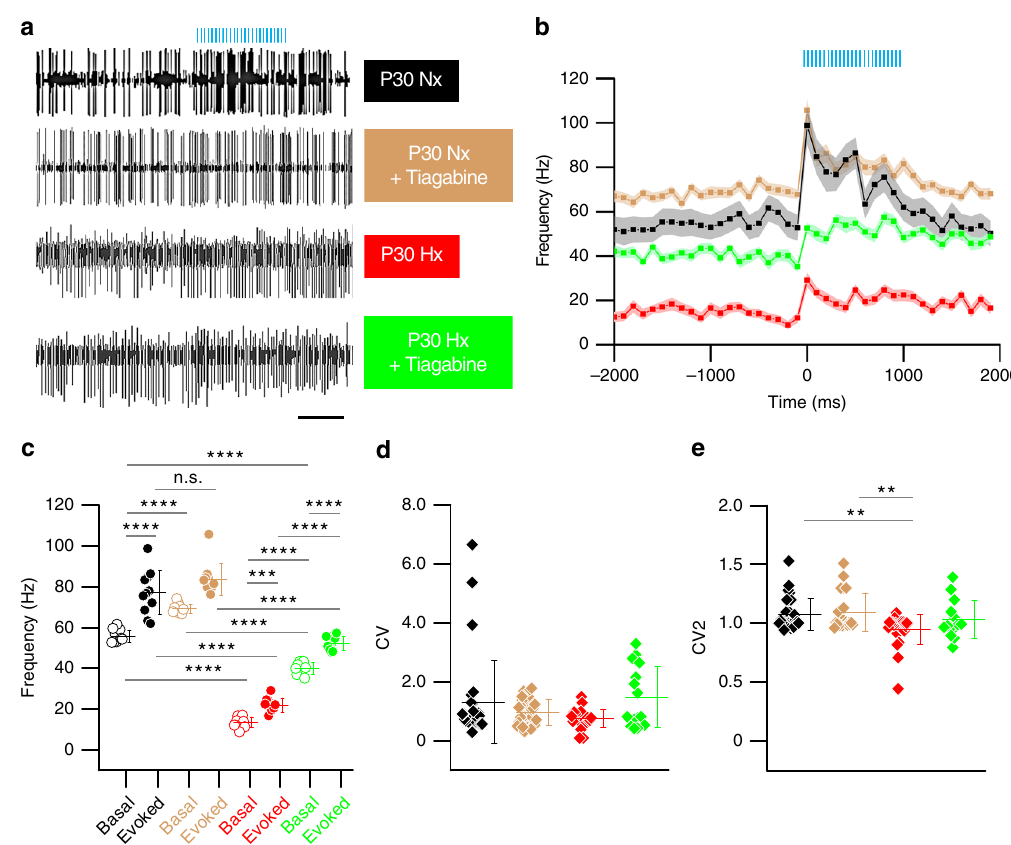
Fig. 8 Pharmacological intervention improves PC simple spike fi ring frequency in Hx Pcp2-Cre mice in vivo. a Representative MEA recordings from PCs in untreated P30 Nx (black), Tiagabine-treated P30 Nx (light brown), untreated P30 Hx (red), and Tiagabine-treated P30 Hx (green) animals. Scale 500 ms. b Mean SS fi ring frequency in animals from untreated P30 Nx group (black, n = 31 PCs, SEM — light grey), Tiagabine-treated Nx group (light brown, n = 37 PCs SEM — light tan), untreated Hx group (red, n = 25 PCs, SEM — light red), and Tiagabine-treated Hx group (green, n = 18 PCs, SEM — light green) obtained from 8 – 10 animals per group. c Scatter plot SS fi ring frequency comparison across groups as indicated by legend in a . For all groups, open circles represent basal fi ring and solid circles represent evoked (optostimulated) fi ring. Each circle represents mean fi ring frequency obtained from multiple cells per group for a single sample. Ten successive timepoints were sampled pre-optostimulation and 11 successive timepoints were sampled post- optostimulation. Horizontal lines in each group represent the mean fi ring frequency across time-samples. One-way ANOVA, F (7,80) = 244.7, P < 0.0001, R 2 = 0.9554. d Scatter plot showing coef fi cient of variance of interspike interval (CV) values of basal PC fi ring in Nx and Hx animals. Each diamond represents individual CV values from the same set of PCs for which frequency plots are analyzed in b – c . (One-way ANOVA, F (3,103) = 2.109, P = 0.0377, R 2 = 0.07836). e Scatter plot showing CV2 values of basal PC fi ring in Nx and Hx animals from the same data set as in b – d . (One-way ANOVA, F 5.18, P = 0.0024, R 2 = 0.1487). Scale in a and b represent 500 ms. Error bars in b – e denote SEM. Asterisks represent results of Tukey ’ s